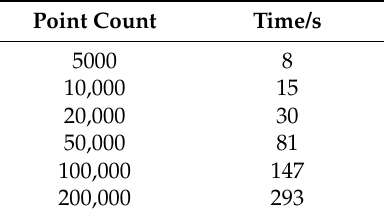
Figure 14. Terrain surface modeling time with respect to the DEM point count. The modeling time was linear dependent to the point count. Table 1. Time consuming experiment with respect to different DEM point